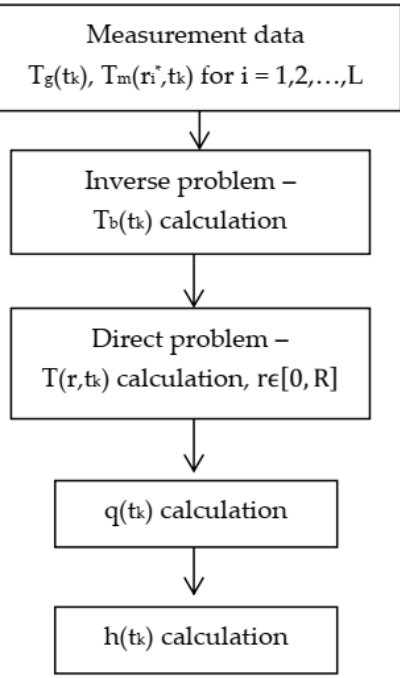
Figure 3. Scheme of the calculation procedure for t k -th time unit.